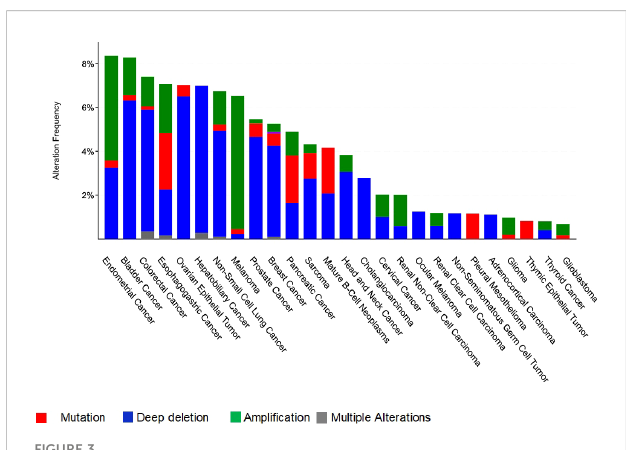
FIGURE 3 Frequency and type of genetic alterations at the MCPH1/BRIT1 locus in different cancer